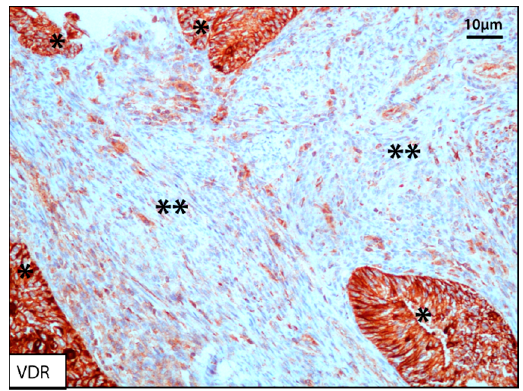
Figure 3. The reprogramming capacity of the tumor stroma is largely due both to the indirect effect of vitamin D on the microbiota and the presence of vitamin D receptor (VDR) on the components of the TME (**). Carcinoma cells (*). Image acquired at 20×.